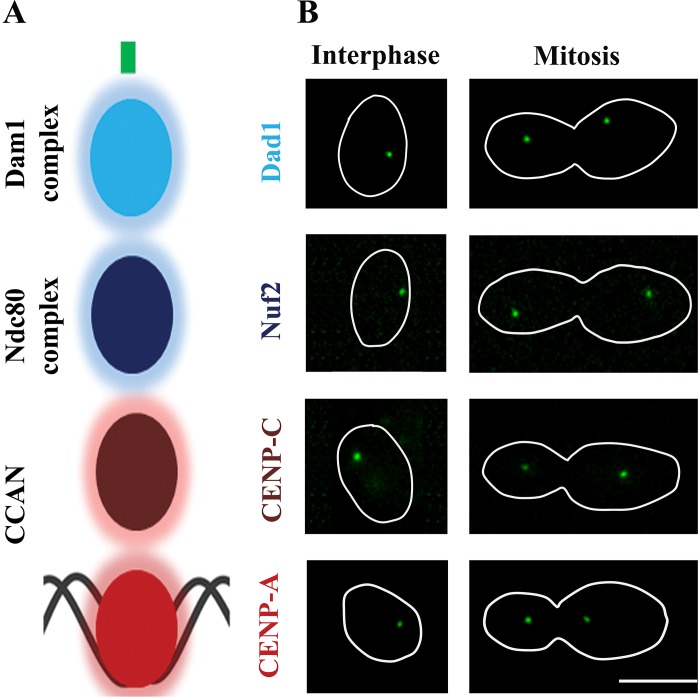
Identification of kinetochore proteins in C. tropicalis.(A) An illustration showing the kinetochore organization in yeasts. (B) Live cell fluorescence microscopic images of indicated proteins at two different stages of the cell cycle: interphase (unbudded) and mitotic (large-budded). Scale bar, 5 μm.